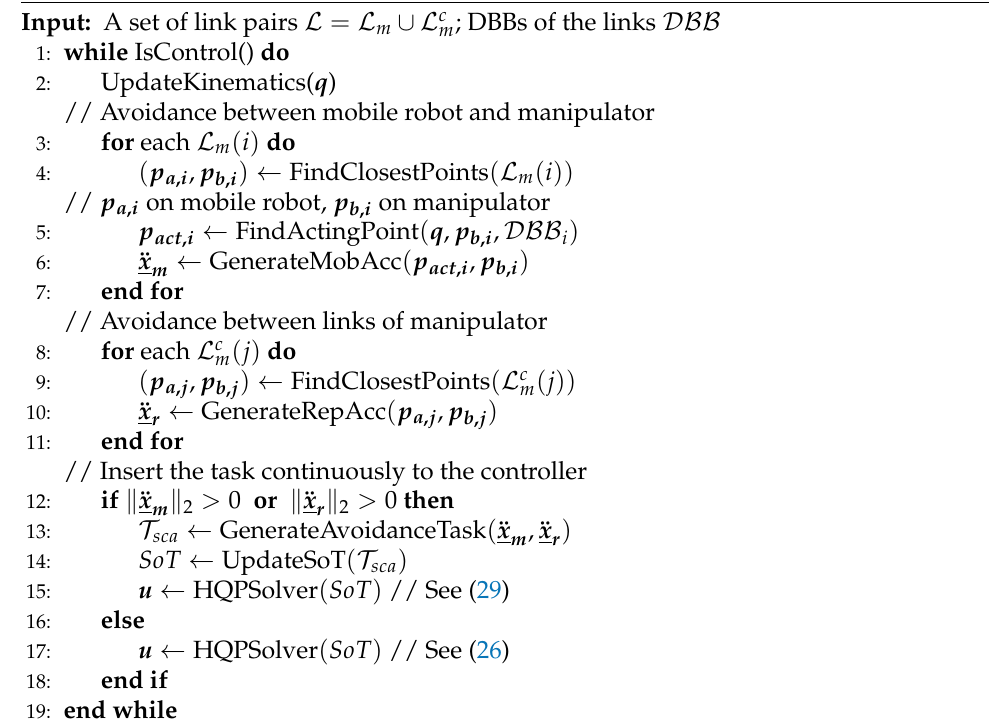
Algorithm 2 Self-Collision